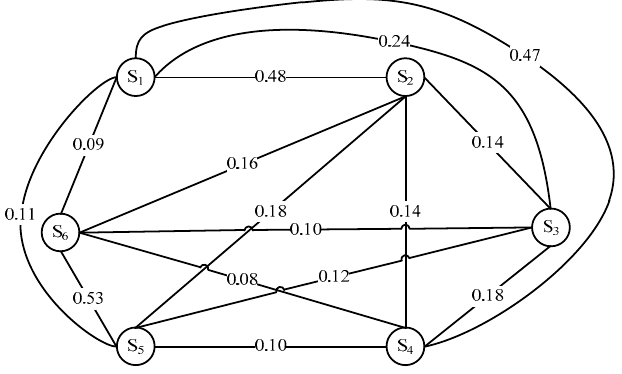
Figure 10. The undirected graph of the weighted similarity.